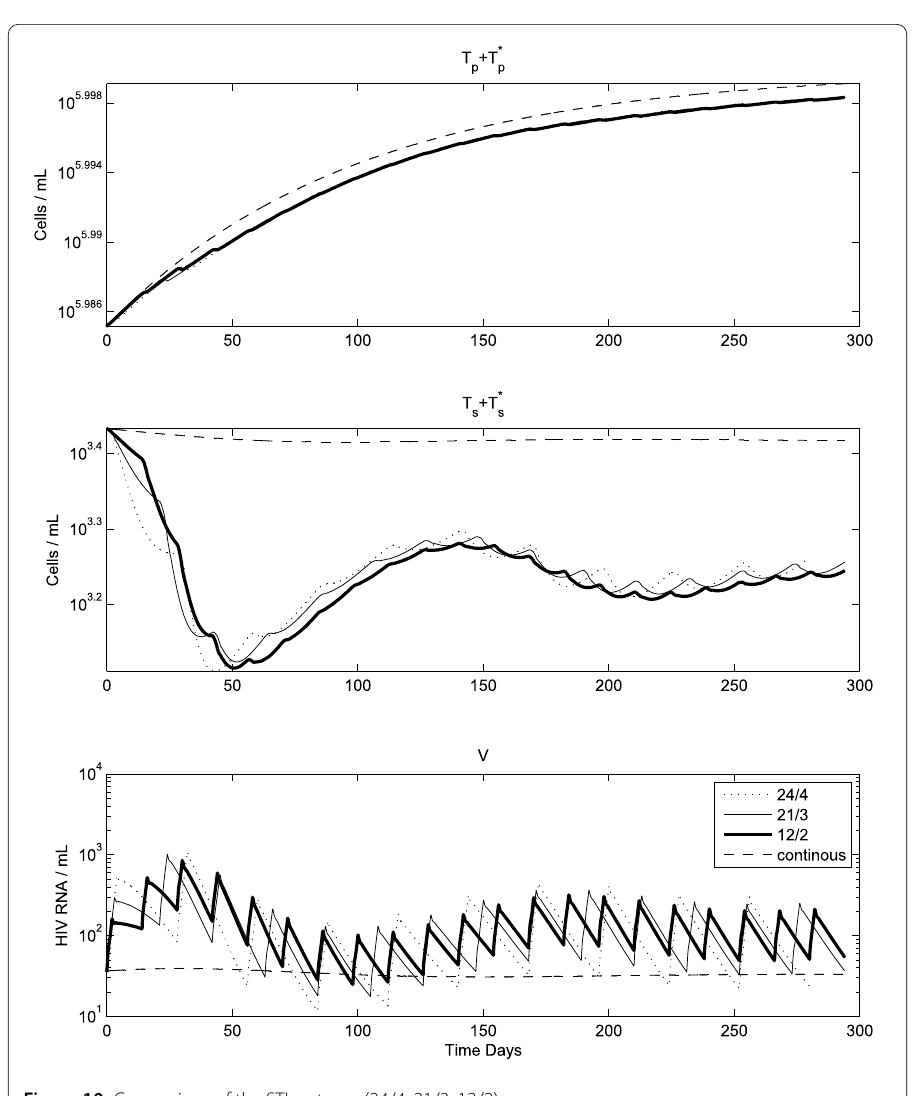
Figure 10 Comparison of the STI systems; (24/4, 21/3,